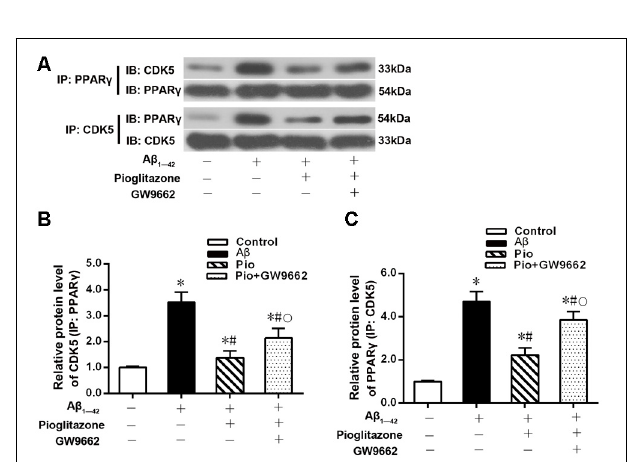
FIGURE 9 | Effects of pioglitazone and A β 1–42 on the binding of CDK5 to PPAR γ in AD model neurons. (A) Representative immunoblots to show reciprocal co-IP experiments in using anti-CDK5 or anti-PPAR γ antibodies. (B) Intergroup comparisons of CDK5 protein levels in immunoprecipitated complexes obtained using anti-PPAR γ antibody. (C) Intergroup comparisons of PPAR γ protein levels in immunoprecipitated complexes obtained using anti-CDK5 antibody. n = 6 wells per group. ∗ P < 0.05 compared to the control group, # P < 0.05 compared to the A β group, ◦ P < 0.05 compared to the Pio